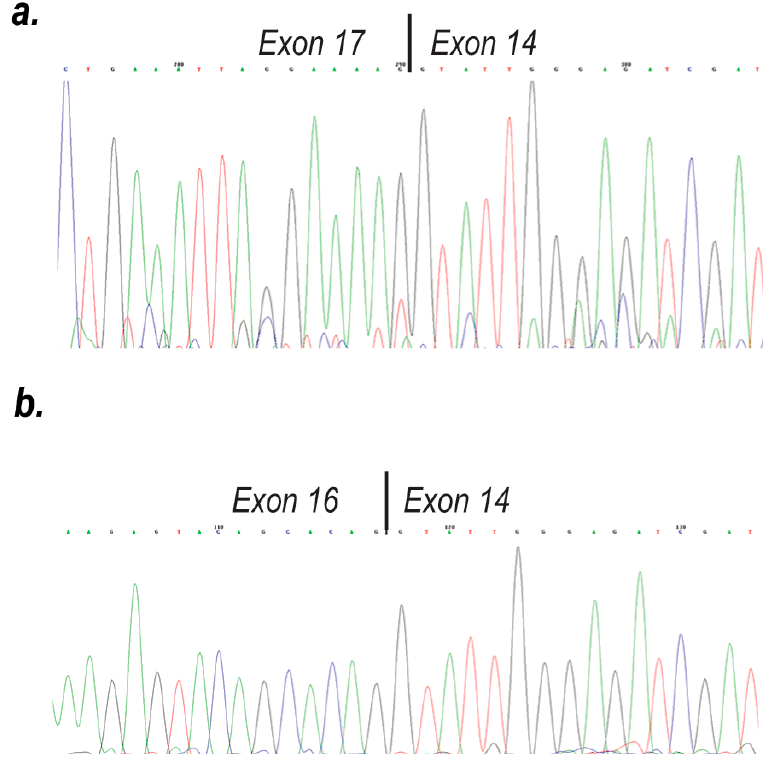
Figure 4. ( a ) Sequence chromatogram showing the duplication of exons 14–17, with exon 17 being spliced to exon 14 across the duplication junction; ( b ) Sequence chromatogram showing the removal